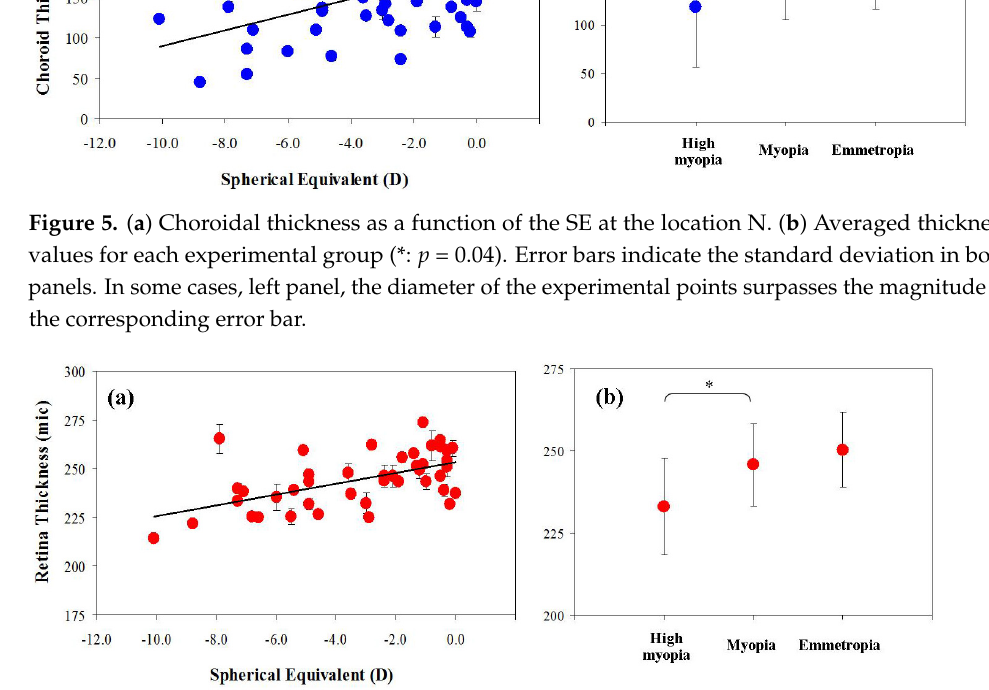
Figure 6. ( a ) Relationship between retinal thickness and refraction at the nasal location. Best linear fit: Tret = 11.66·SE + 292.59. ( b ) Averaged retinal thickness for each group of subjects (*: p = 0.01). Error bars indicate the standard deviation in both panels. In some cases, left panel, the diameter of the experimental points surpasses the magnitude of the corresponding error